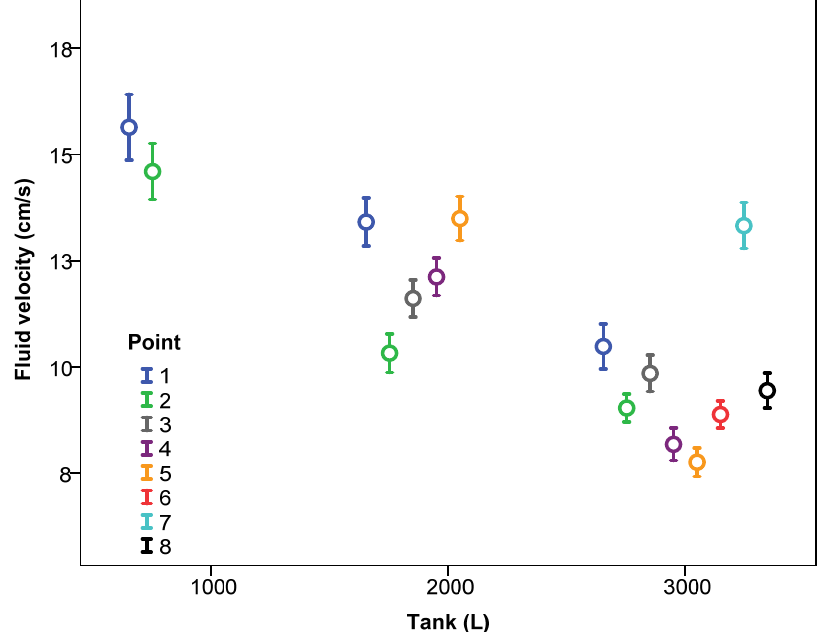
Figure 9. Fluid velocity (mean ± 95% confidence interval) at the measurement points of the four sections (all data included).